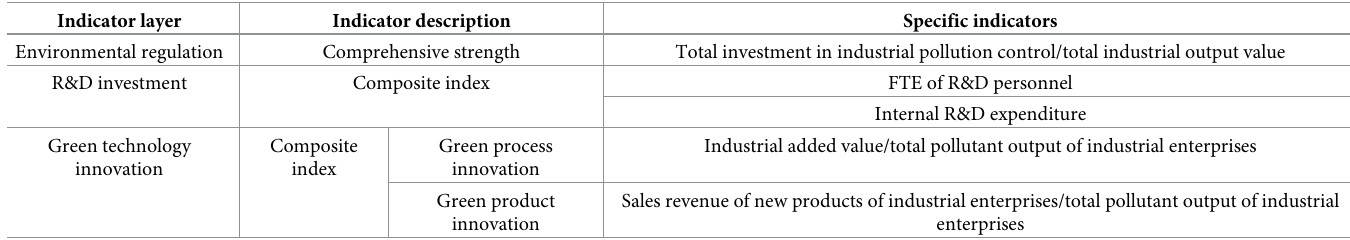
Table 1. Explanation of environmental regulation, R&D investment and green technology innovation index